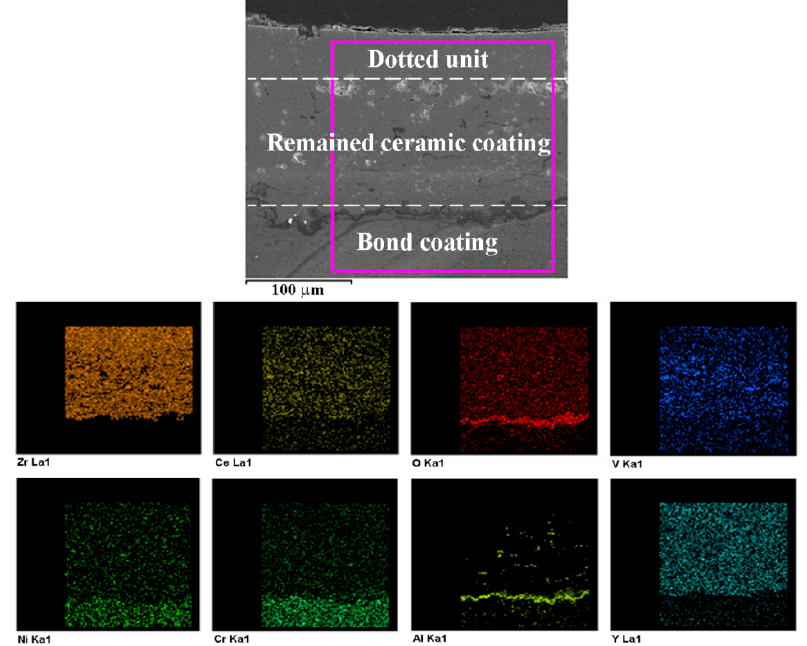
Figure 14. EDS elemental mapping of the cross section of the dotted unit in the dotted specimen after the hot corrosion test.